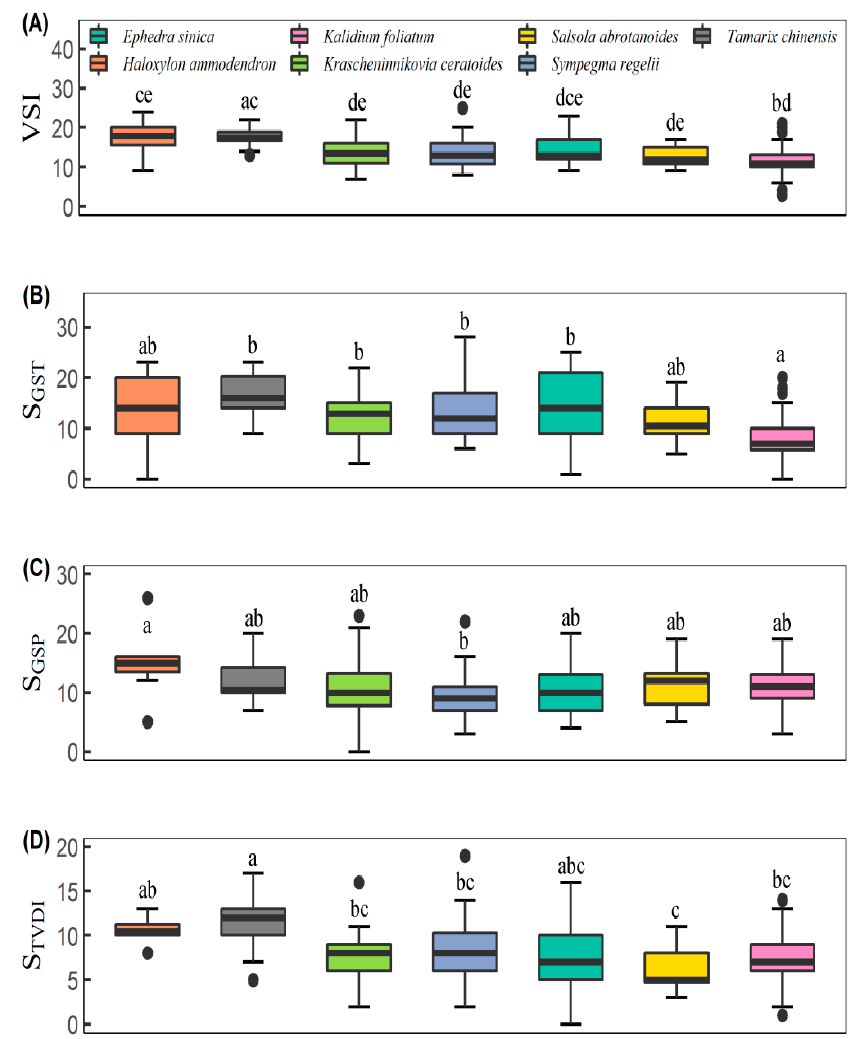
Figure 3. Comparisons of VSI ( A ) and its climatic weights among desert scrub communities. Panels ( B – D ) displayed the weights of mean temperature and sum precipitation during the plant growing season (noted as S GST and S GSP , respectively) as well as the temperature vegetation dryness index (S TVDI ). Different lowercase letters indicate significant differences among species.